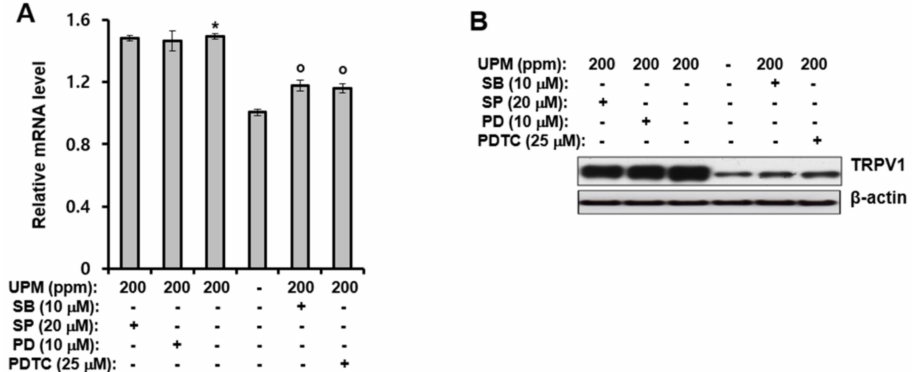
Figure 2. Urban particulate matter activates activator protein-1 (AP-1)-, cAMP response element (CRE)-, and nuclear factor kappa B (NF- κ B)-signaling. HaCaT cells were transfected with the AP-Luc ( A ), NF- κ B-Luc ( B ), or CRE-Luc ( C ) reporter along with a Renilla-luciferase expression vector driven by a thymidine-kinase promoter using DharmaFECT ® Duo transfection reagent according to the manufacturer’s protocols. After 24 h, the cells were incubated in the presence of the indicated concentrations of UPM for 14 h. The cells were then harvested, lysed, and assayed. ( D ) HaCaT cells were treated with the indicated concentrations of UPM for 1 h. The cell lysates were then analyzed using the Multi-Target Sandwich ELISA Kit. The results were verified using three independent experiments, each of which was conducted in duplicate. * p < 0.05 vs. control. The data are expressed as the mean ± SD. PMA, Phorbol 12-myristate 13-acetate; Fk, forskolin; TNF- α , tumor necrosis factor- α .